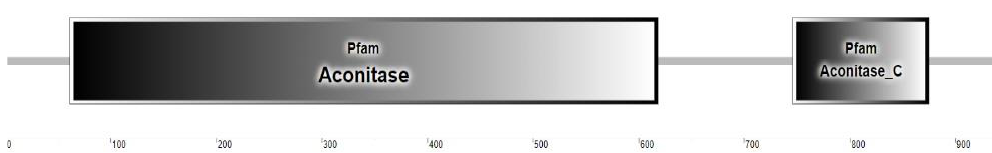
Figure 1. Sequence characterization of Sb IRP-1. ( A ) Nucleotide and deduced amino acid sequences of Sb IRP-1. Nucleotides and amino acids are numbered along the right margin. The initiation codon (atg) and a termination codon (tga) are presented in bold. The aconitase domain is marked in gray and the aconitase C-terminal domain is marked in cyan. ( B ) Protein domains of Sb IRP-1 predicted by